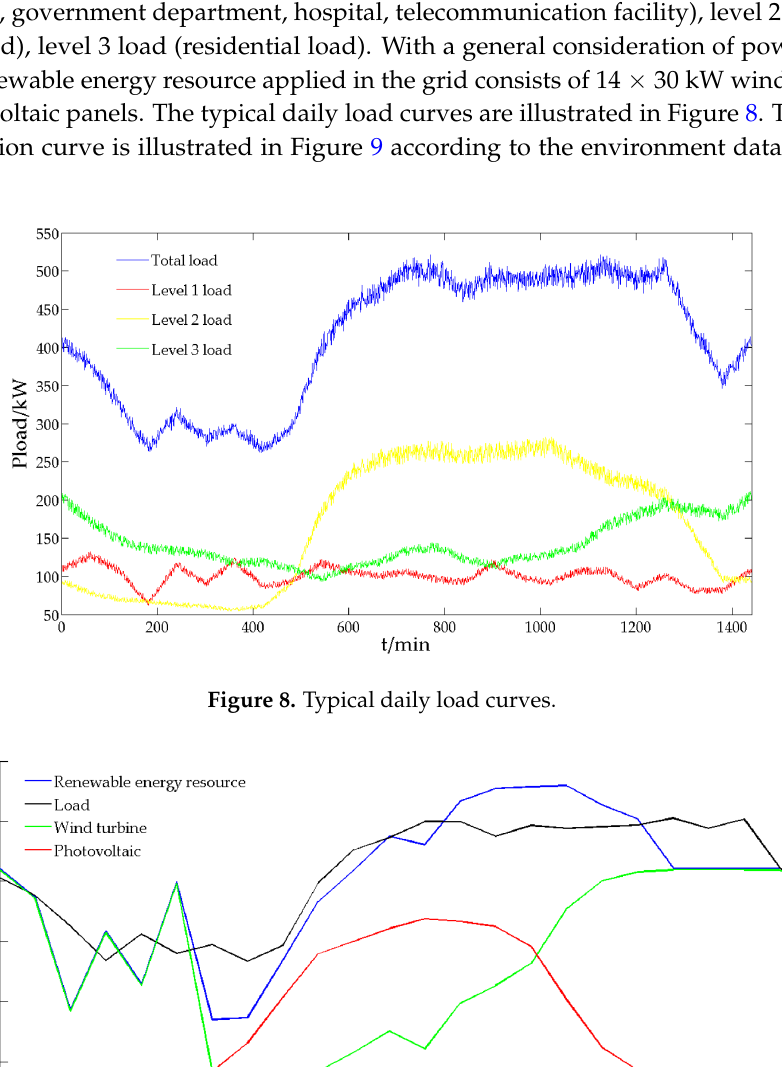
Figure 9. Renewable energy generation curves. Table 7. Environmental